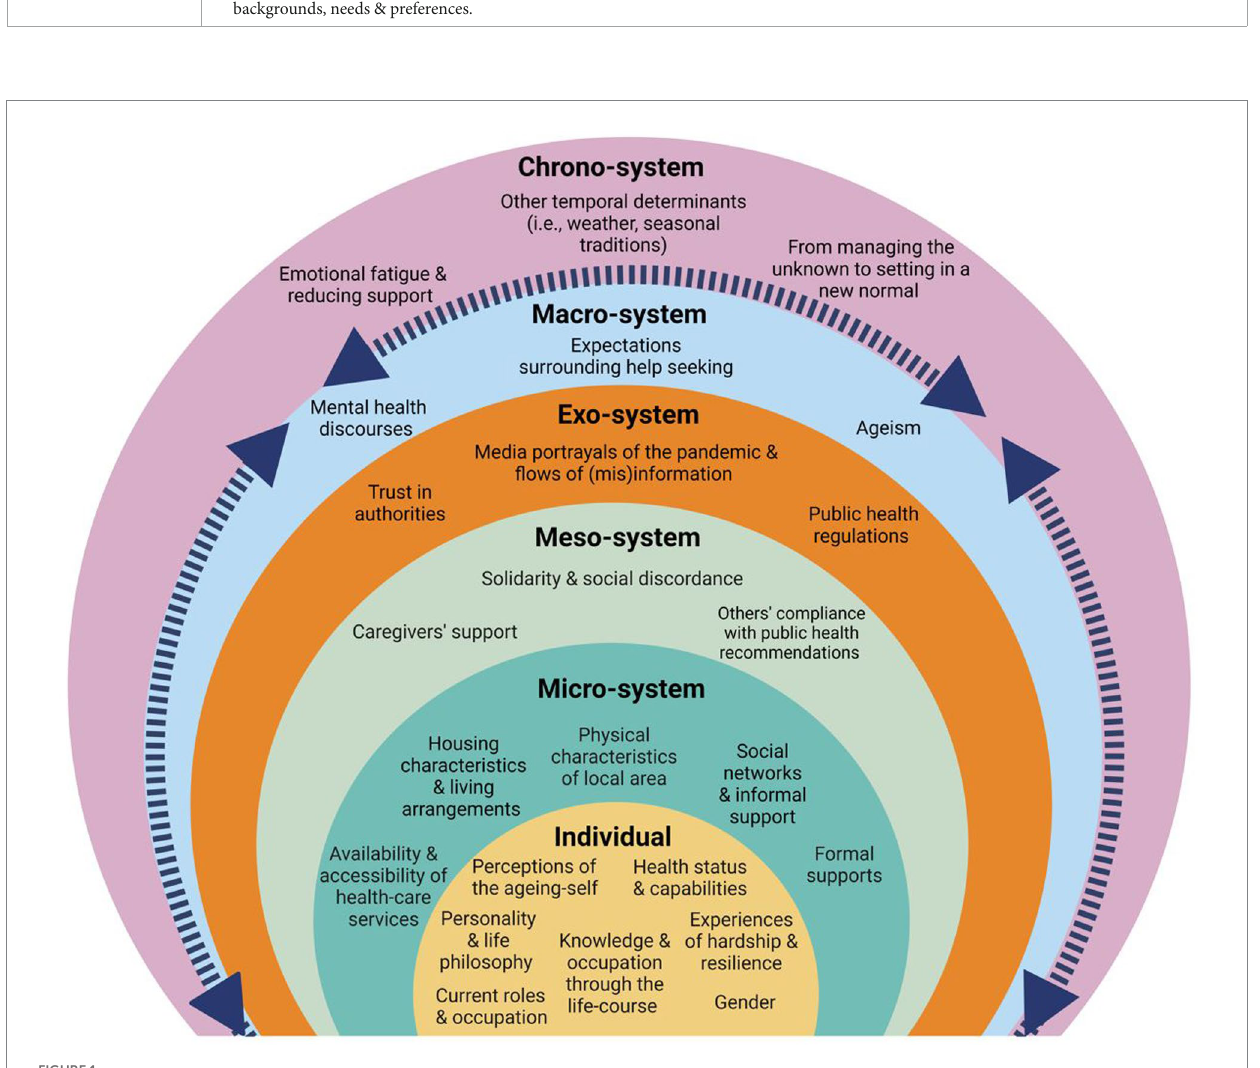
FIGURE 1 Socio-ecological determinants identified at each level.